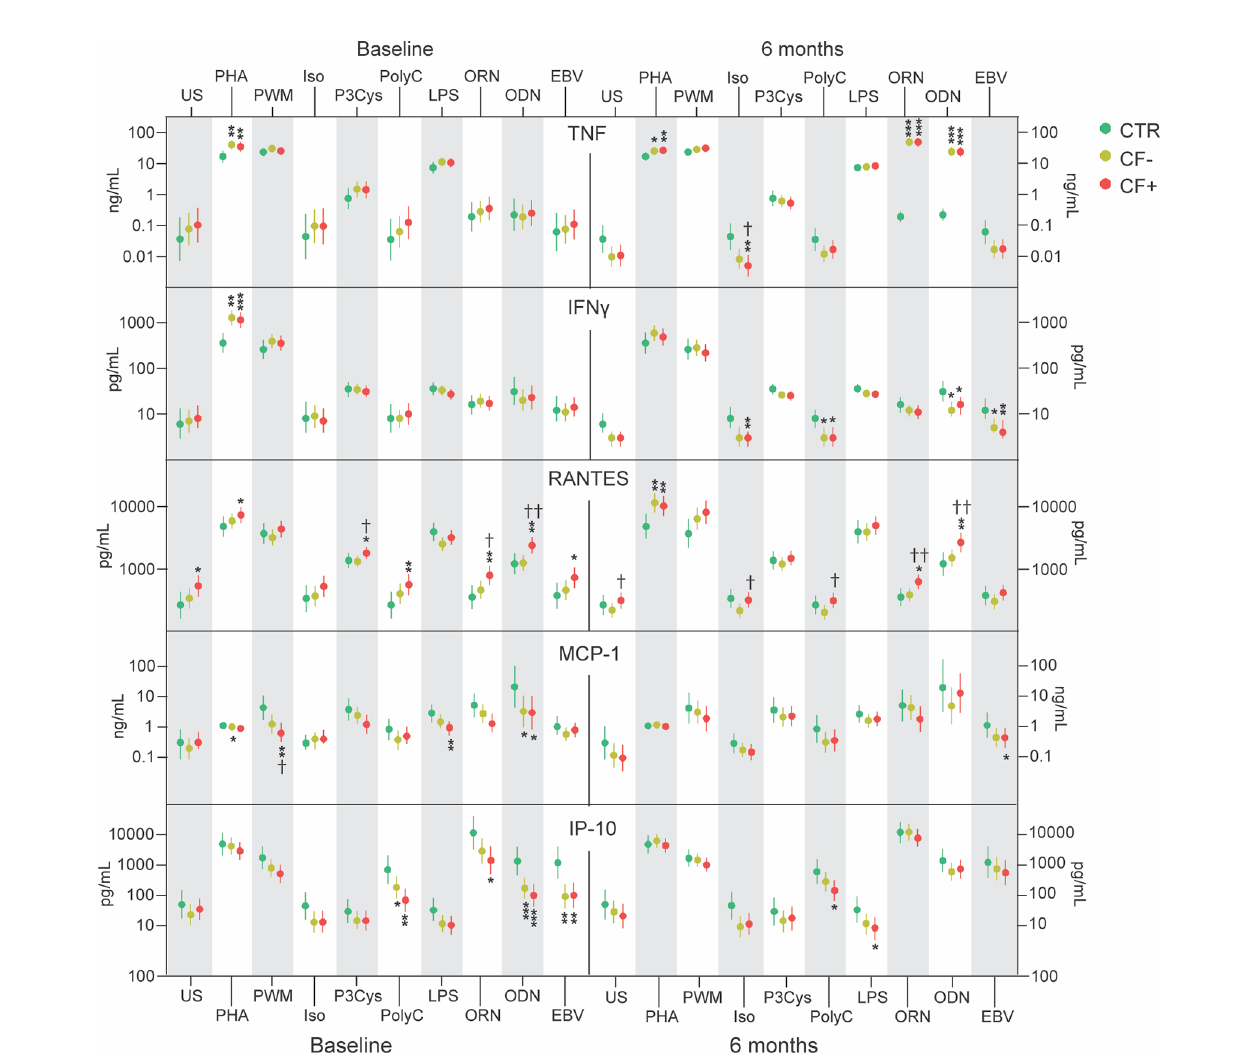
FIGURE 2 | Supernatant levels of TNF, IFN- g , RANTES, MCP-1 and IP-10 in cell cultures of PBMC from healthy controls (CTR) and EBV-patients with and without chronic fatigue (CF+ and CF-, respectively) at baseline and after 6 months. *p<0.05, **p<0.01, ***p<0.001 CF+ and CF- vs HC. † p<0.05, †† p<0.01 CF+ vs